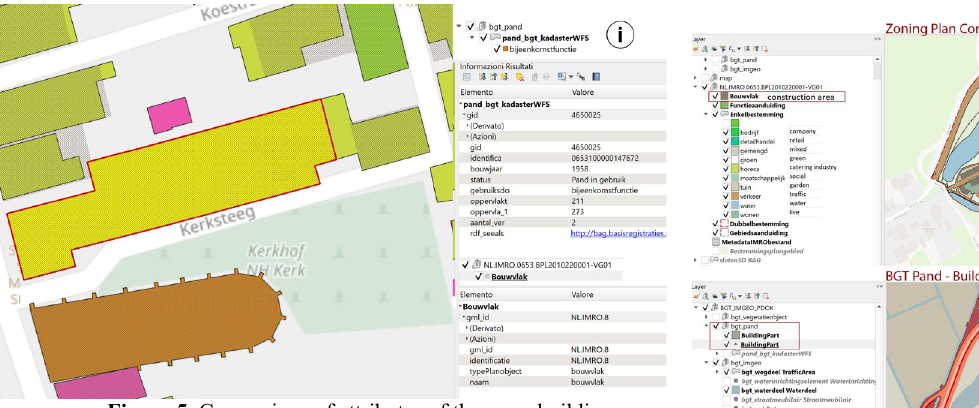
Figure 5. Comparison of attributes of the same building geometries of BGT and BAG datasets. Table 2. Example of comparison and investigation of the building selected in Figure 5 , to check attribute and value similarities (in bold attributes with the same meaning, highlighted in blue the attribute referred to existing linked data).